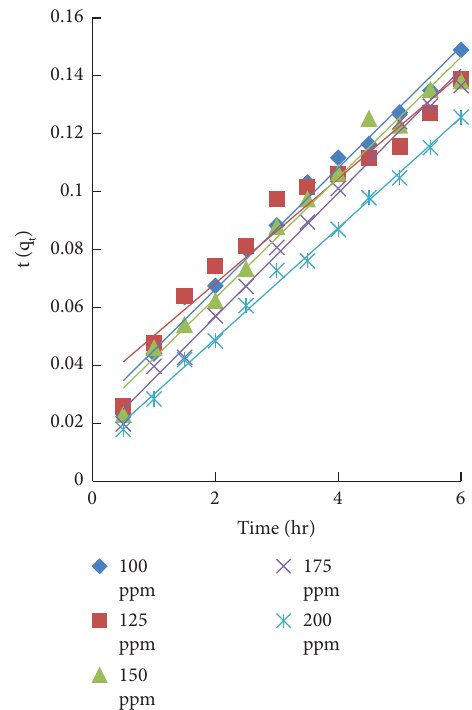
Figure 14: Pseudo-second-order kinetic plots for the adsorption of MB onto PVB/ben at 30 ° C and pH